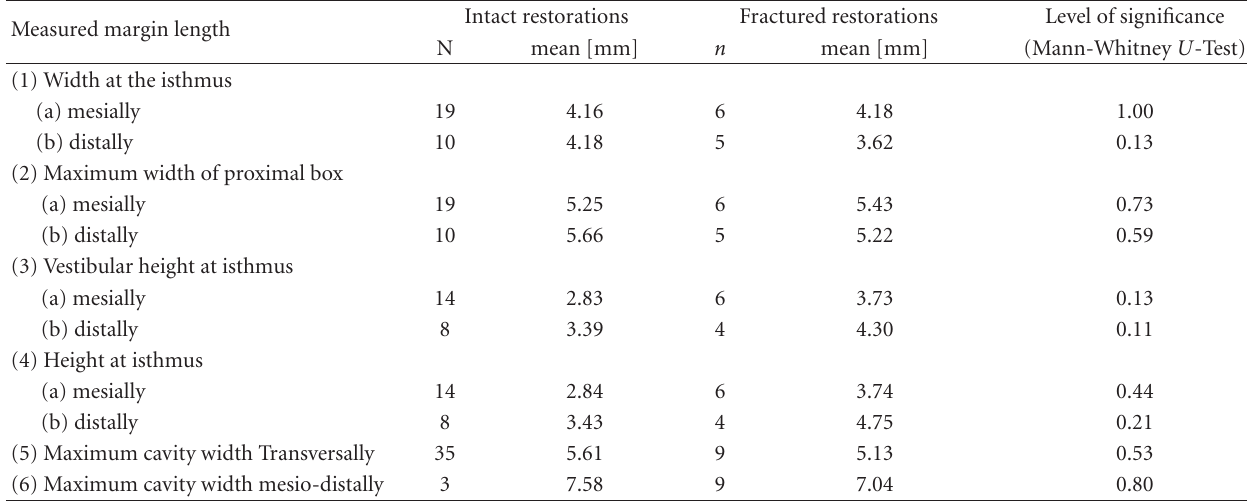
Table 3: Cavity size related to survival of restorations after one